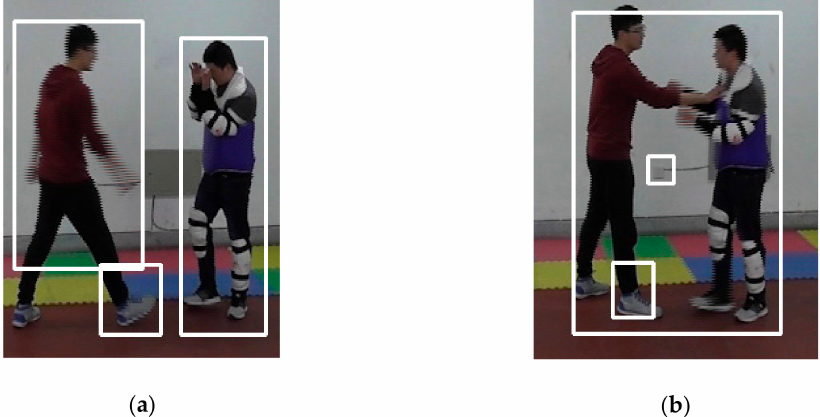
Figure 6. Two examples of unexpected circumscribed rectangular frames: ( a ) one part separated from the whole and ( b ) a redundant circumscribed rectangular